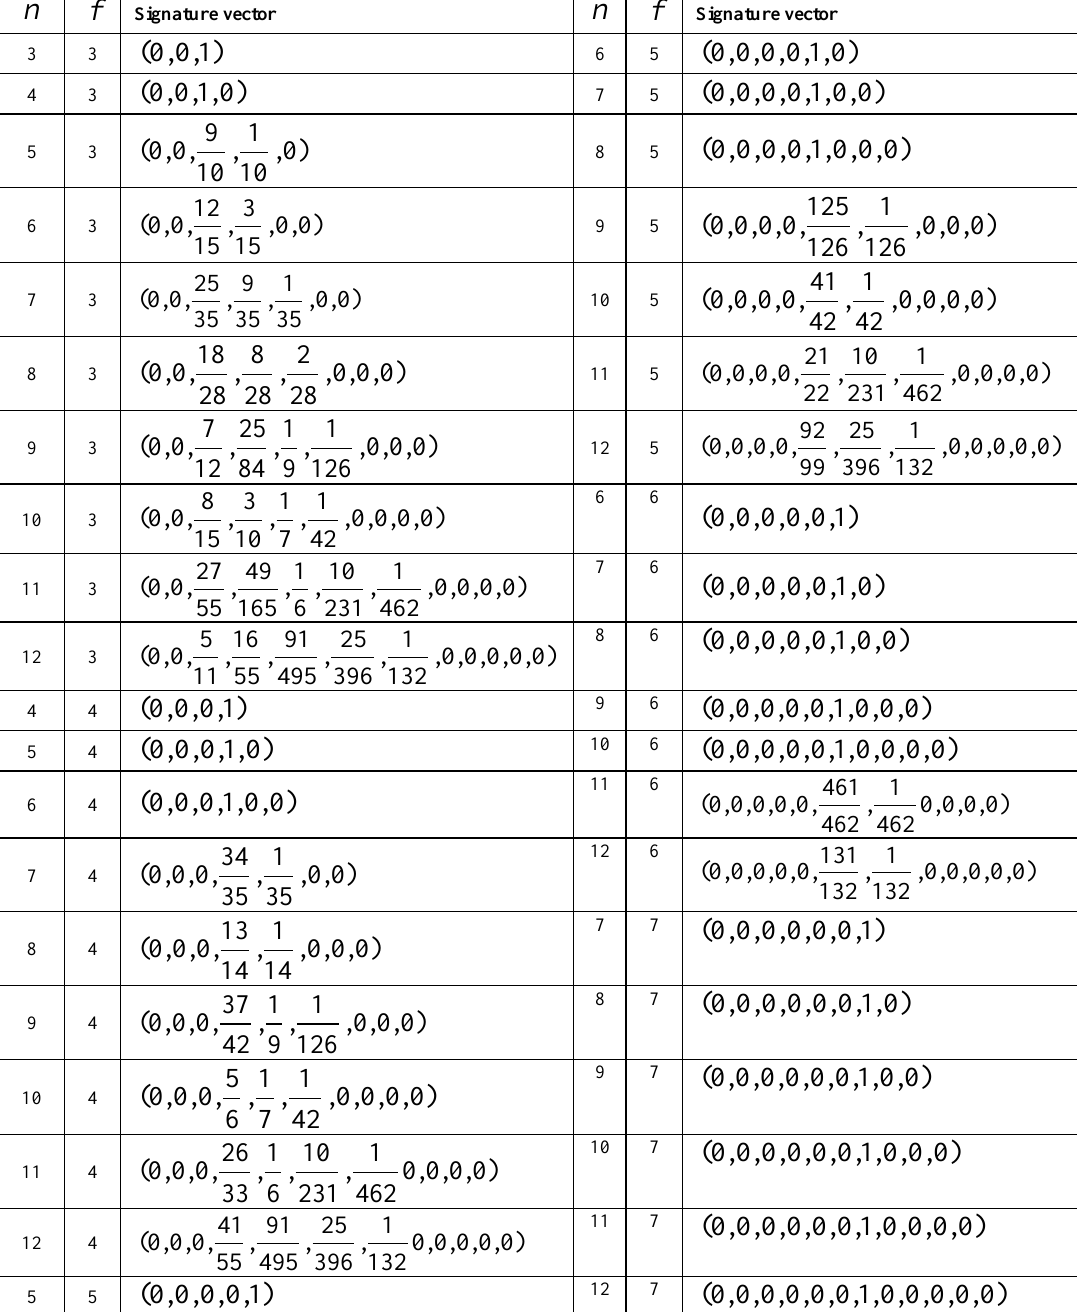
Table 2. Signature vector of < n , f , 2> systems for different values of n , f